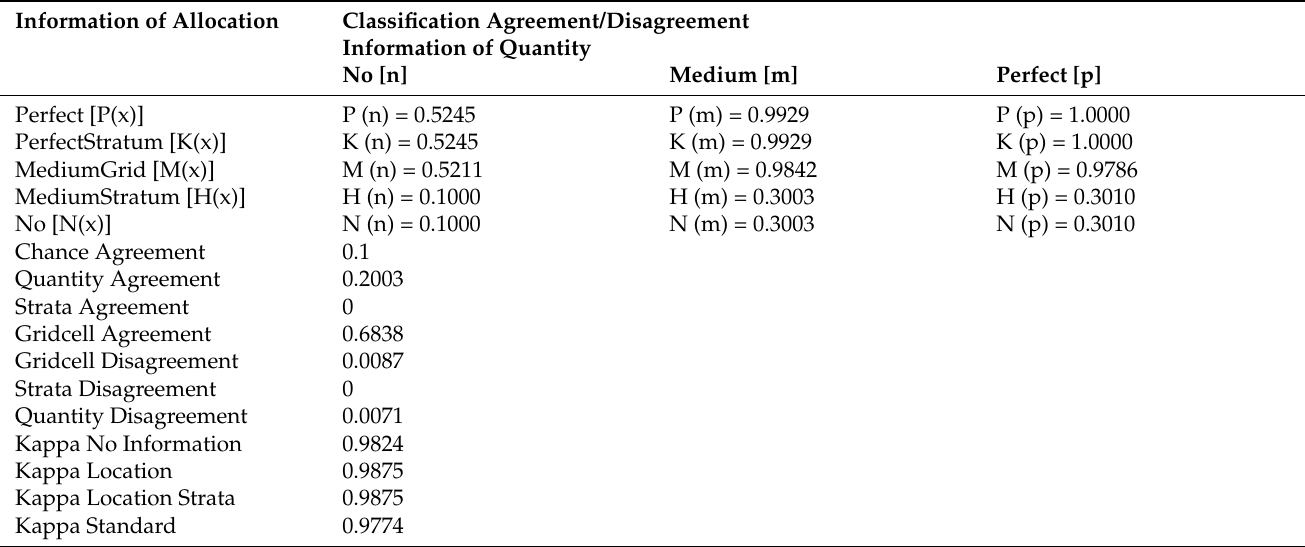
Table A5. Land use/land cover prediction model validation